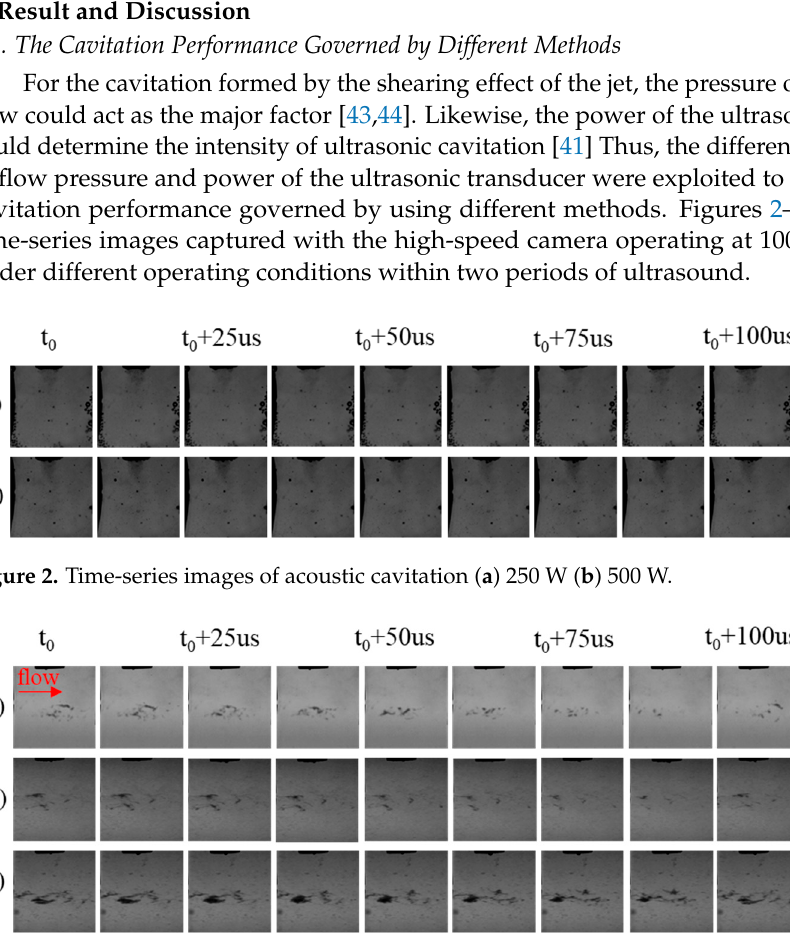
Figure 3. Time-series images of hydrodynamic-acoustic cavitation under the inlet pressure of 1.5 MPa ( a ) Without ultrasound ( b ) 250 W ( c ) 500 W.